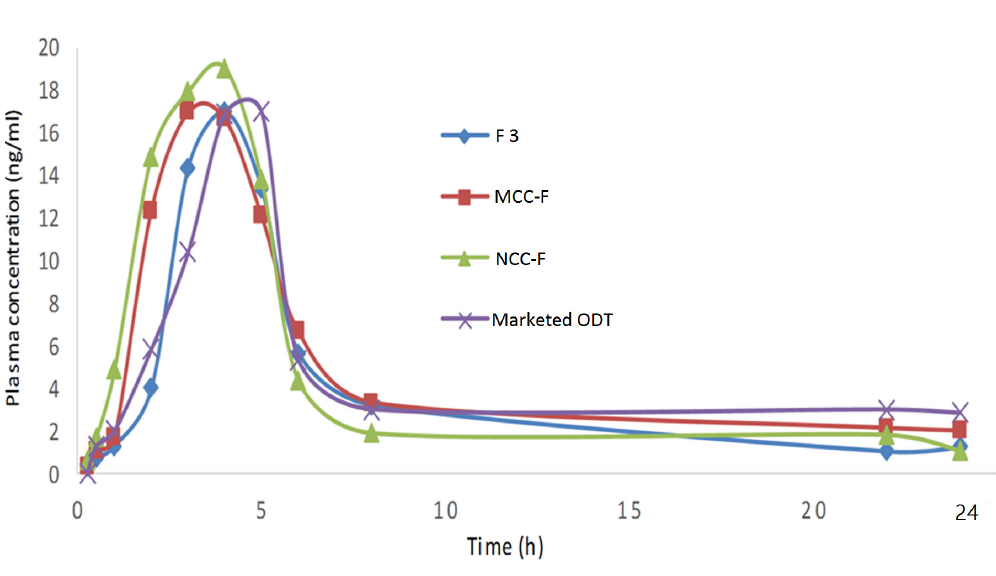
FIGURE 10 - In vivo bioavailability graph of oral dispersible films of F3, MCC-F, NCC-F with marketed oral disintegrating tablet towards male Wister rats, n = 4 and used drug (5 mg/kg) over 24 h. Results represented as mean ± SD, n=4; (p ≥